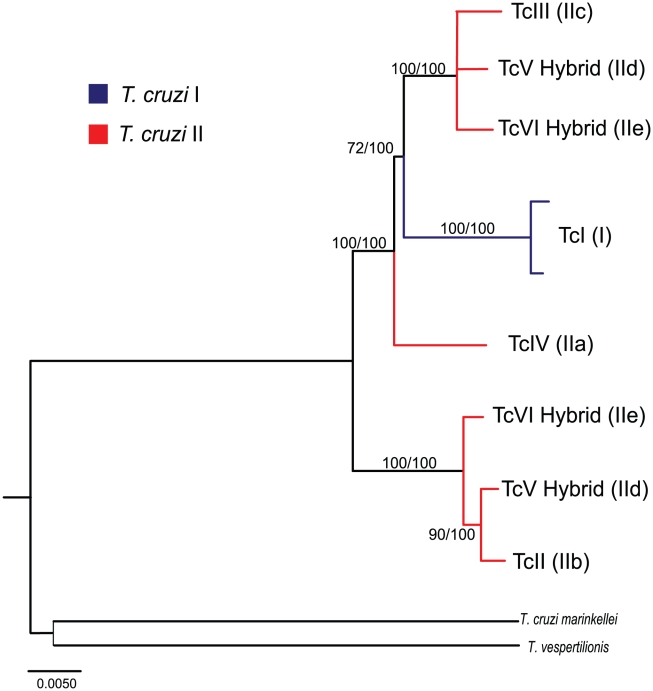
Maximum likelihood tree of concatenated data set.Data set consists of 31 nuclear loci and 1 mitochondrial region (COII-ND1), totaling 26,329 nucleotides per strain. Numbers above and below branches are Bootstrap (from ML analyses) and Bayesian support values, respectively. Taxon names represent the six major DTUs. Scale bar in number of substitutions per site.